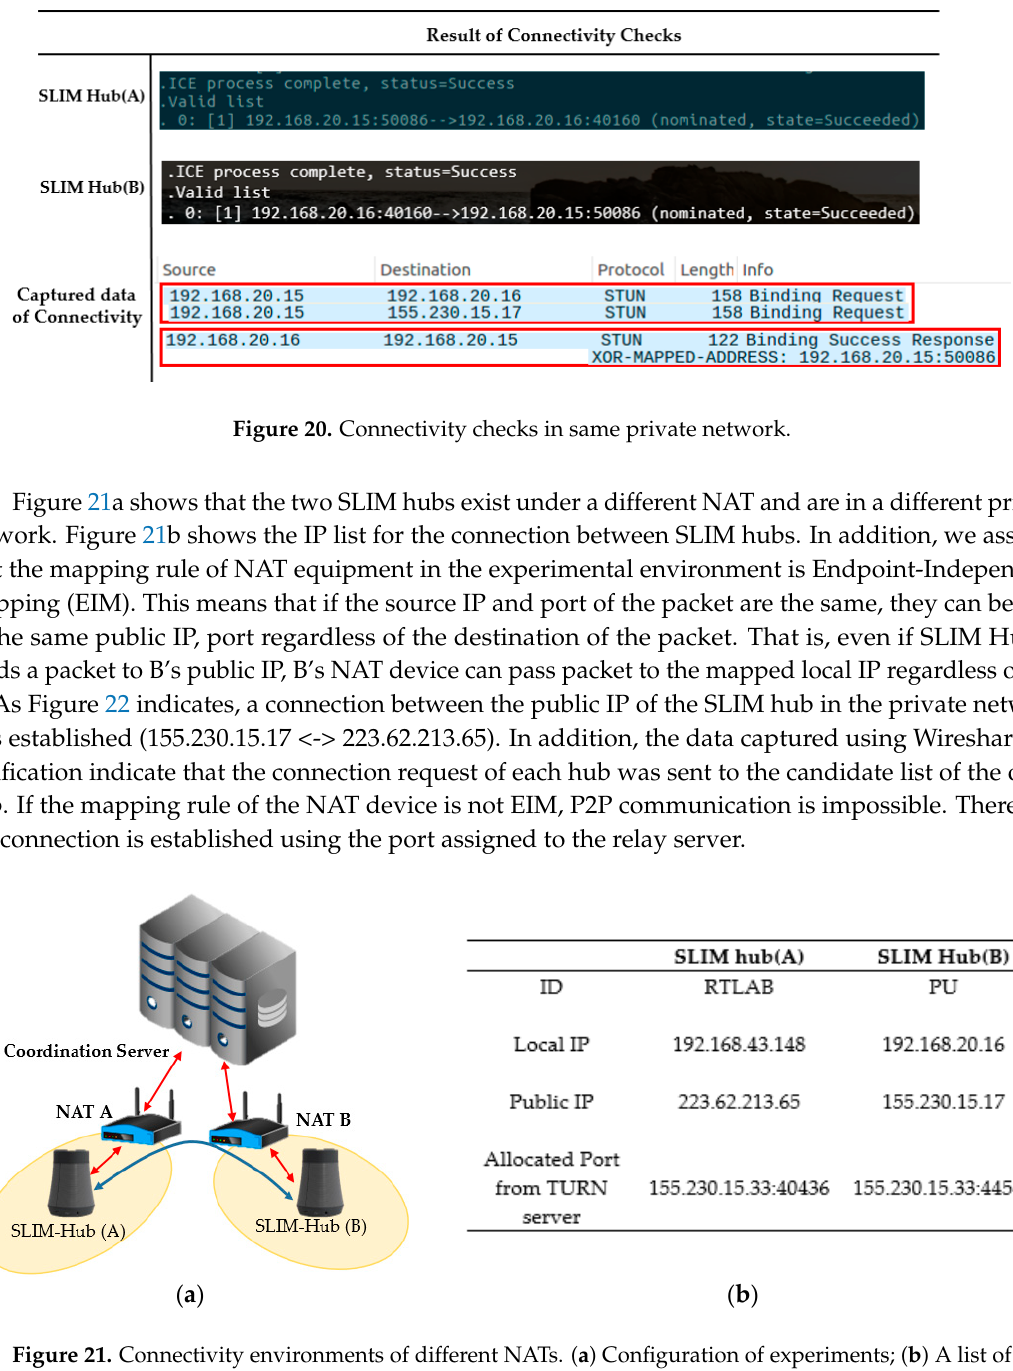
Figure 19. Connectivity environments of same NAT. ( a ) Configuration of experiment; ( b ) A list of SLIM hub’s ID and IP information.